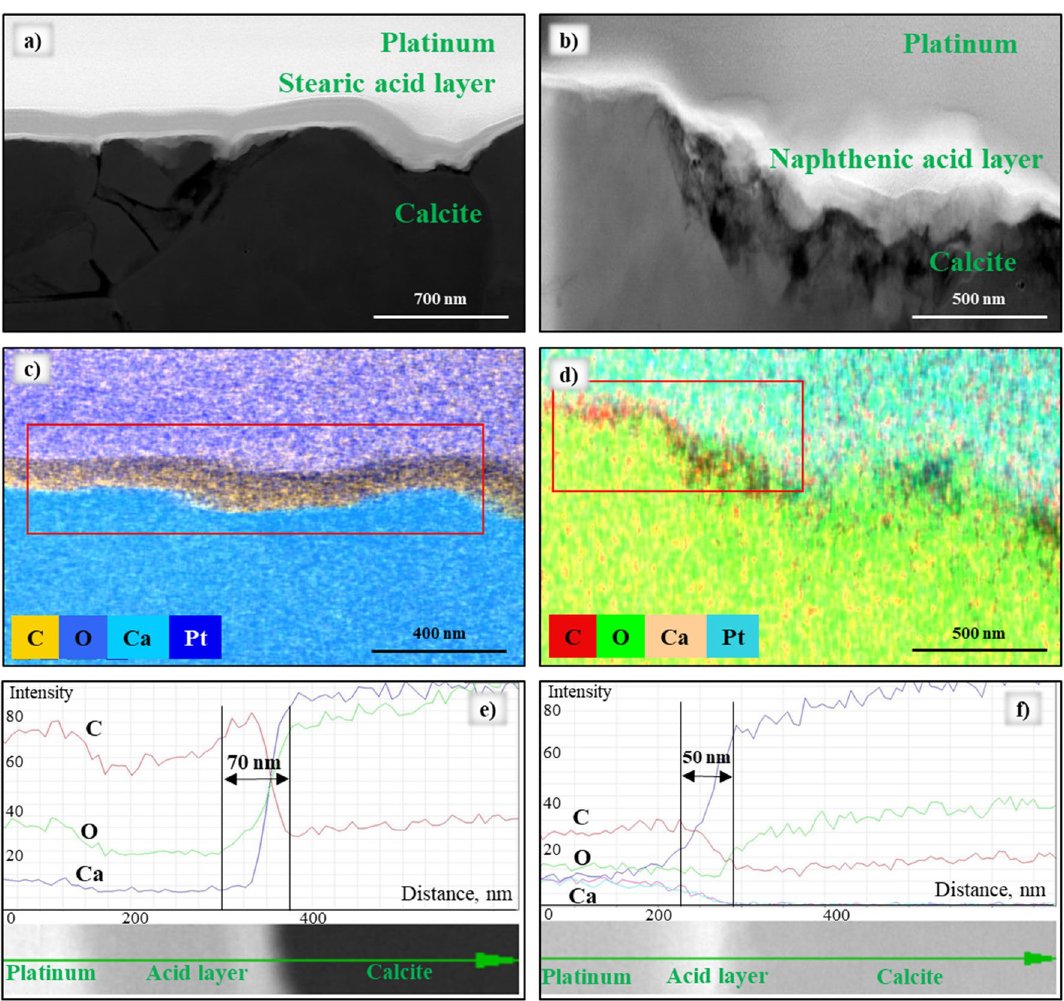
Figure 5. ( a , b ) HAADF-STEM images of cross-sections of the samples after aging in stearic and naphthenic acid (with platinum layer on the top for protection); ( c , d ) EDX mapping images collected illustrate distributions of all elements (C, O, Ca and Pt); ( e , f ) EDX signals of C, O, Ca and Pt observed.